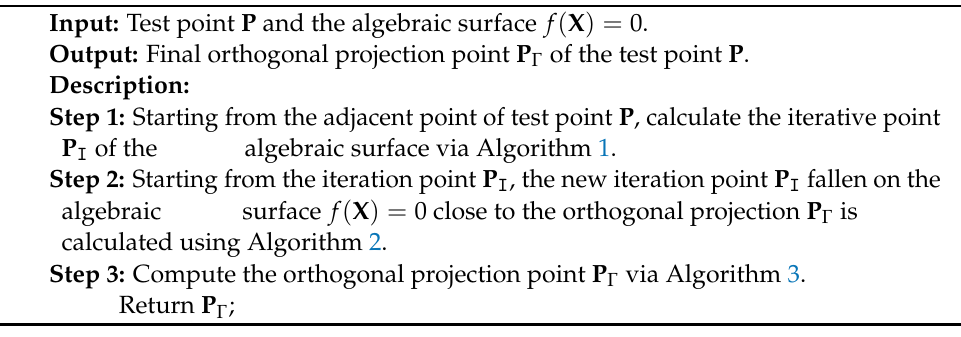
Algorithm 4: The complete hybrid geometry strategy algorithm for point or- thogonal projection onto an algebraic surface.